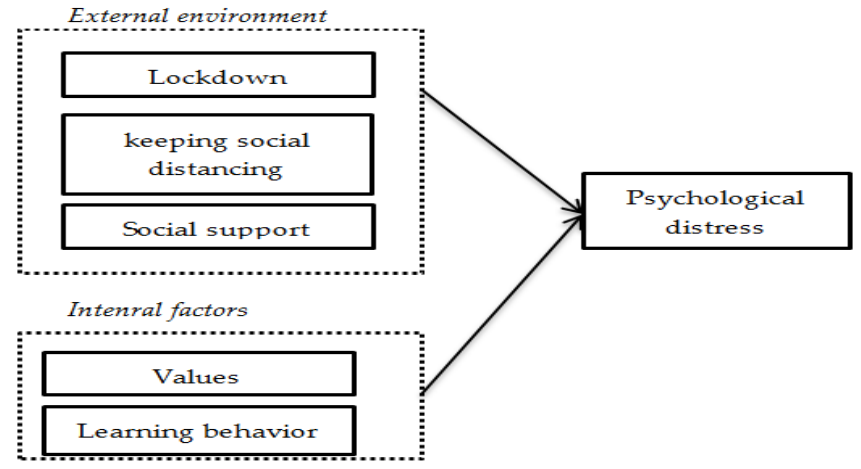
Figure 1. Analytical framework of international students’ psychological distress.